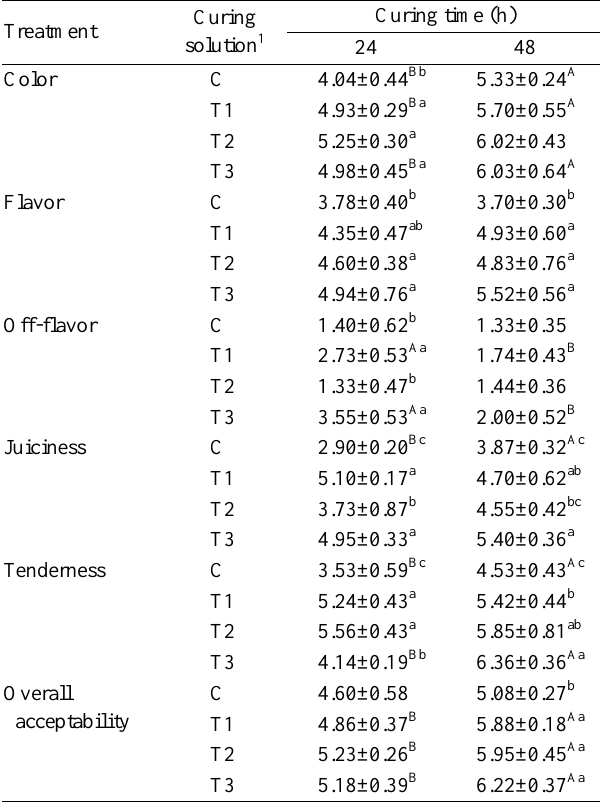
Table 3. Effect of curing time on the sensory evaluation of beef jerky